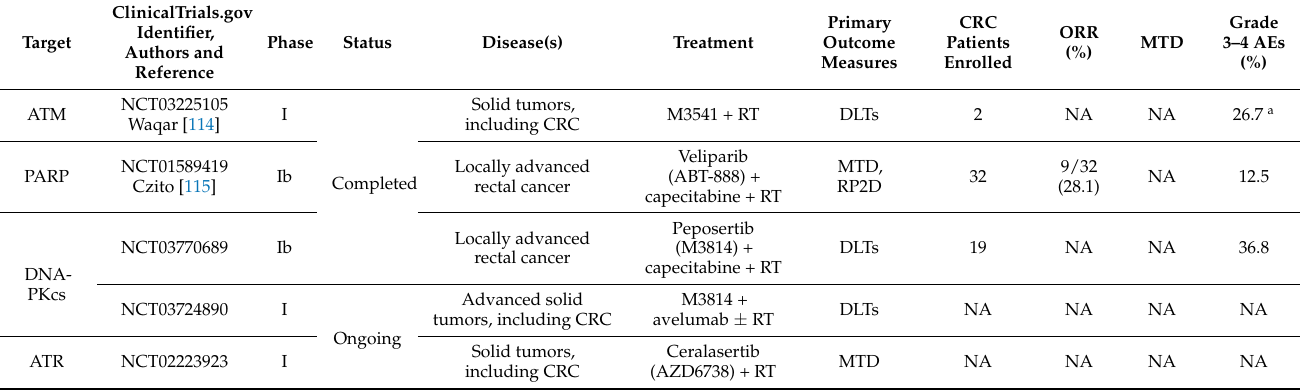
Table 1. Completed or ongoing clinical trials investigating the potential role of DDR and DNA repair pathways inhibitors combined with RT in